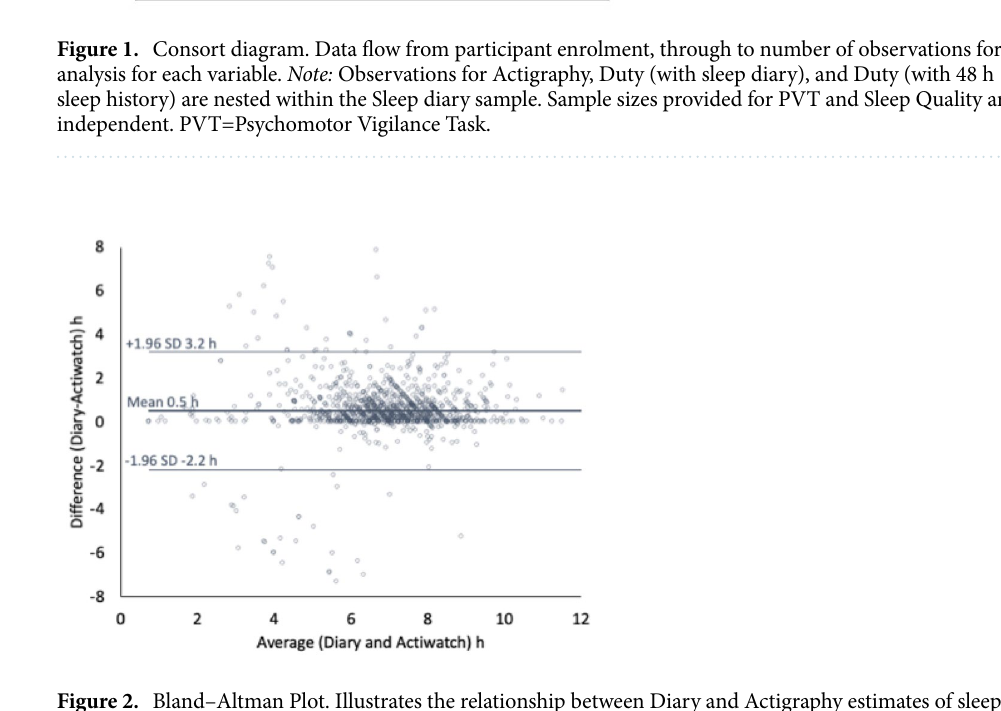
Figure 2. Bland–Altman Plot. Illustrates the relationship between Diary and Actigraphy estimates of sleep in the 24 h prior to starting duty. The mean difference (diff) and 95% Confidence Intervals are indicated by the horizontal lines. The self-reported (i.e., diary) sleep duration was on average, 30 mins longer than more objective (i.e., actigraphy)